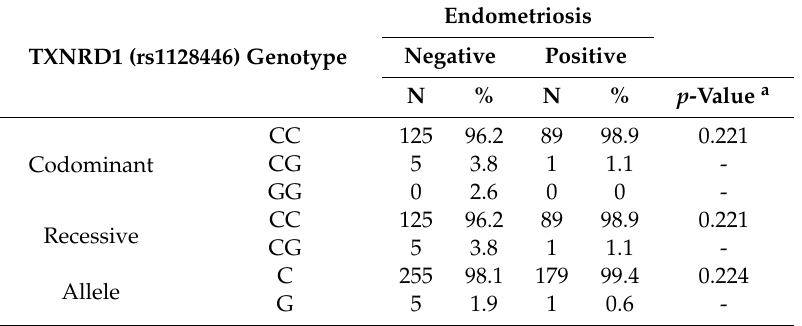
Table 4. Frequencies of TXNRD1 (rs1128446) polymorphism among women with or without endometriosis.